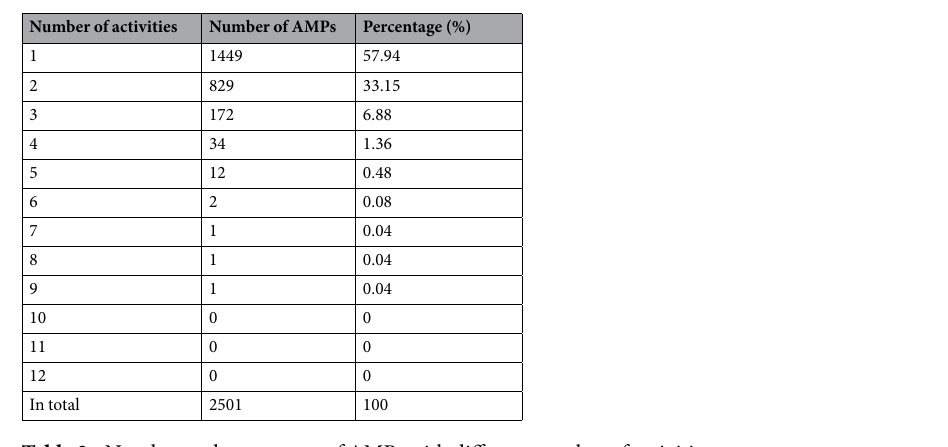
Table 2. Number and percentage of AMPs with different number of activities.